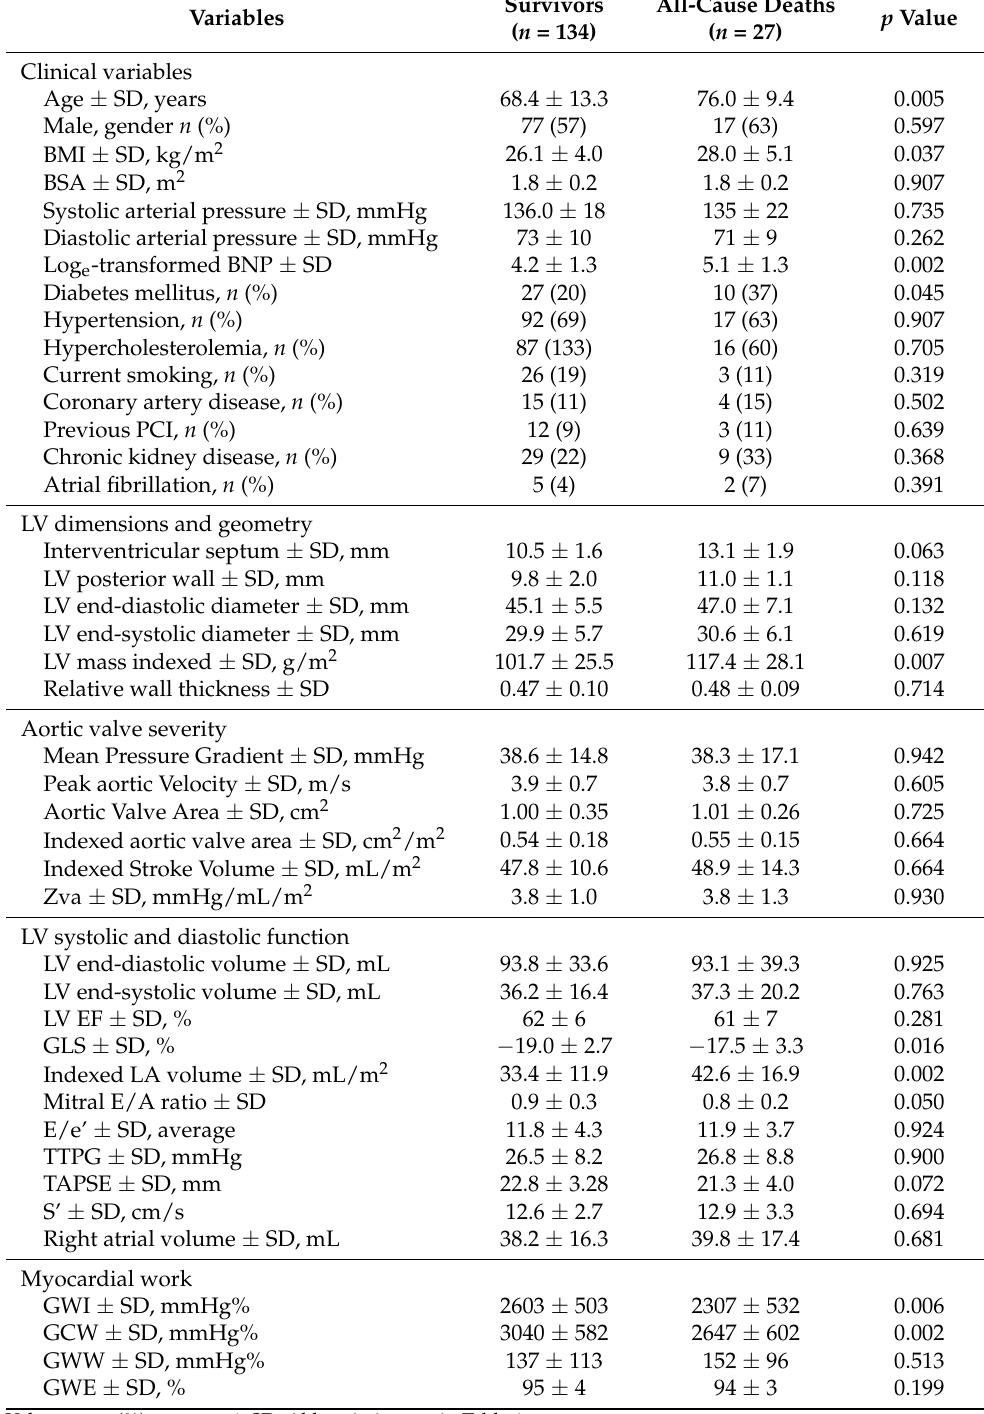
Table 3. Comparison between asymptomatic AS patients who died or not during follow-up.